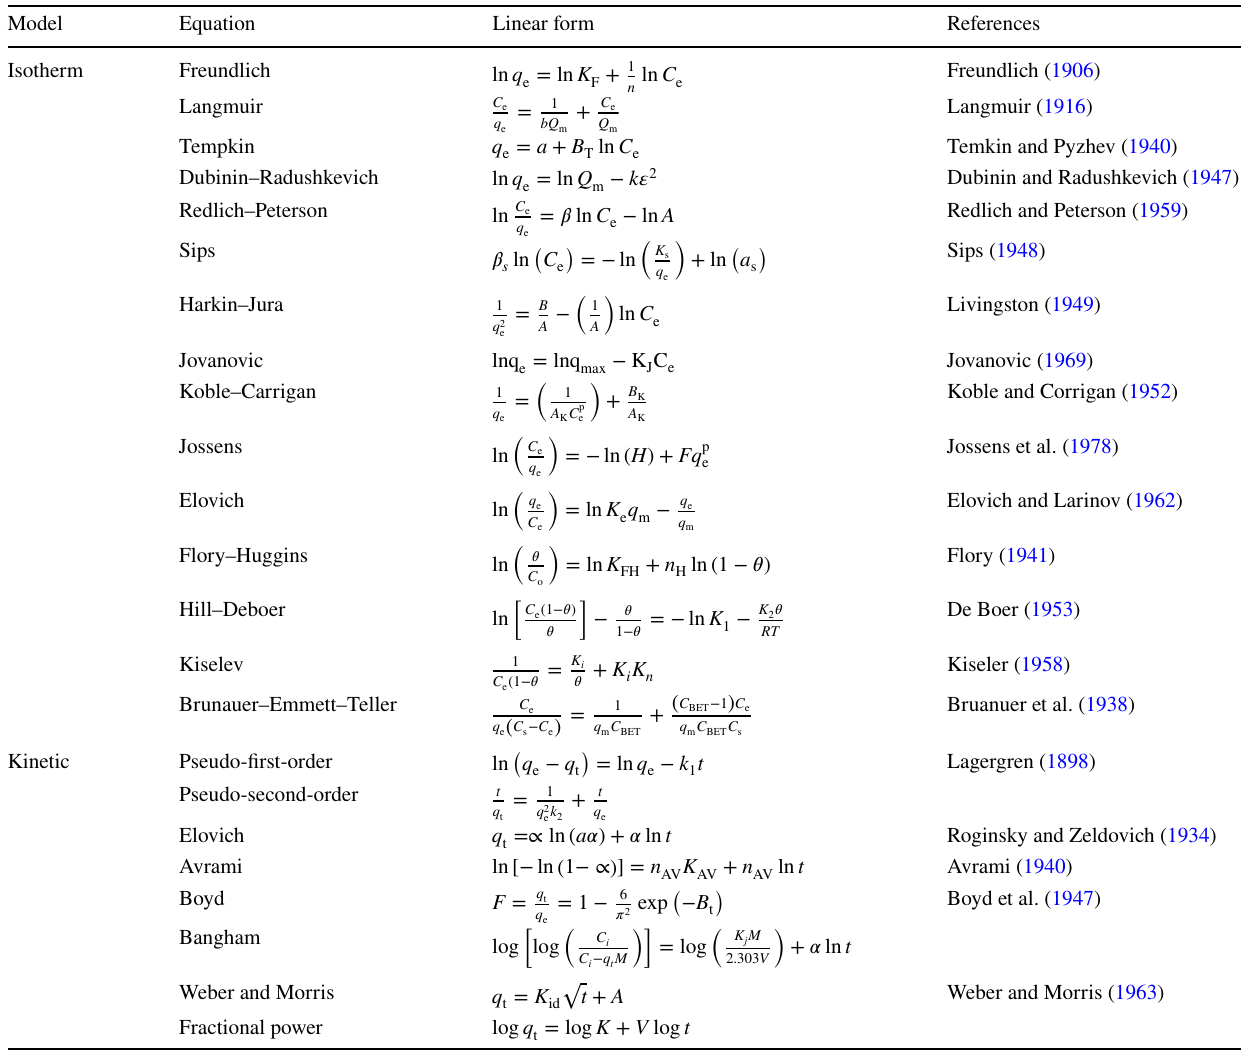
Table 1 List of adsorption isotherms and kinetics models used for the elucidation of pollutants removal from wastewater